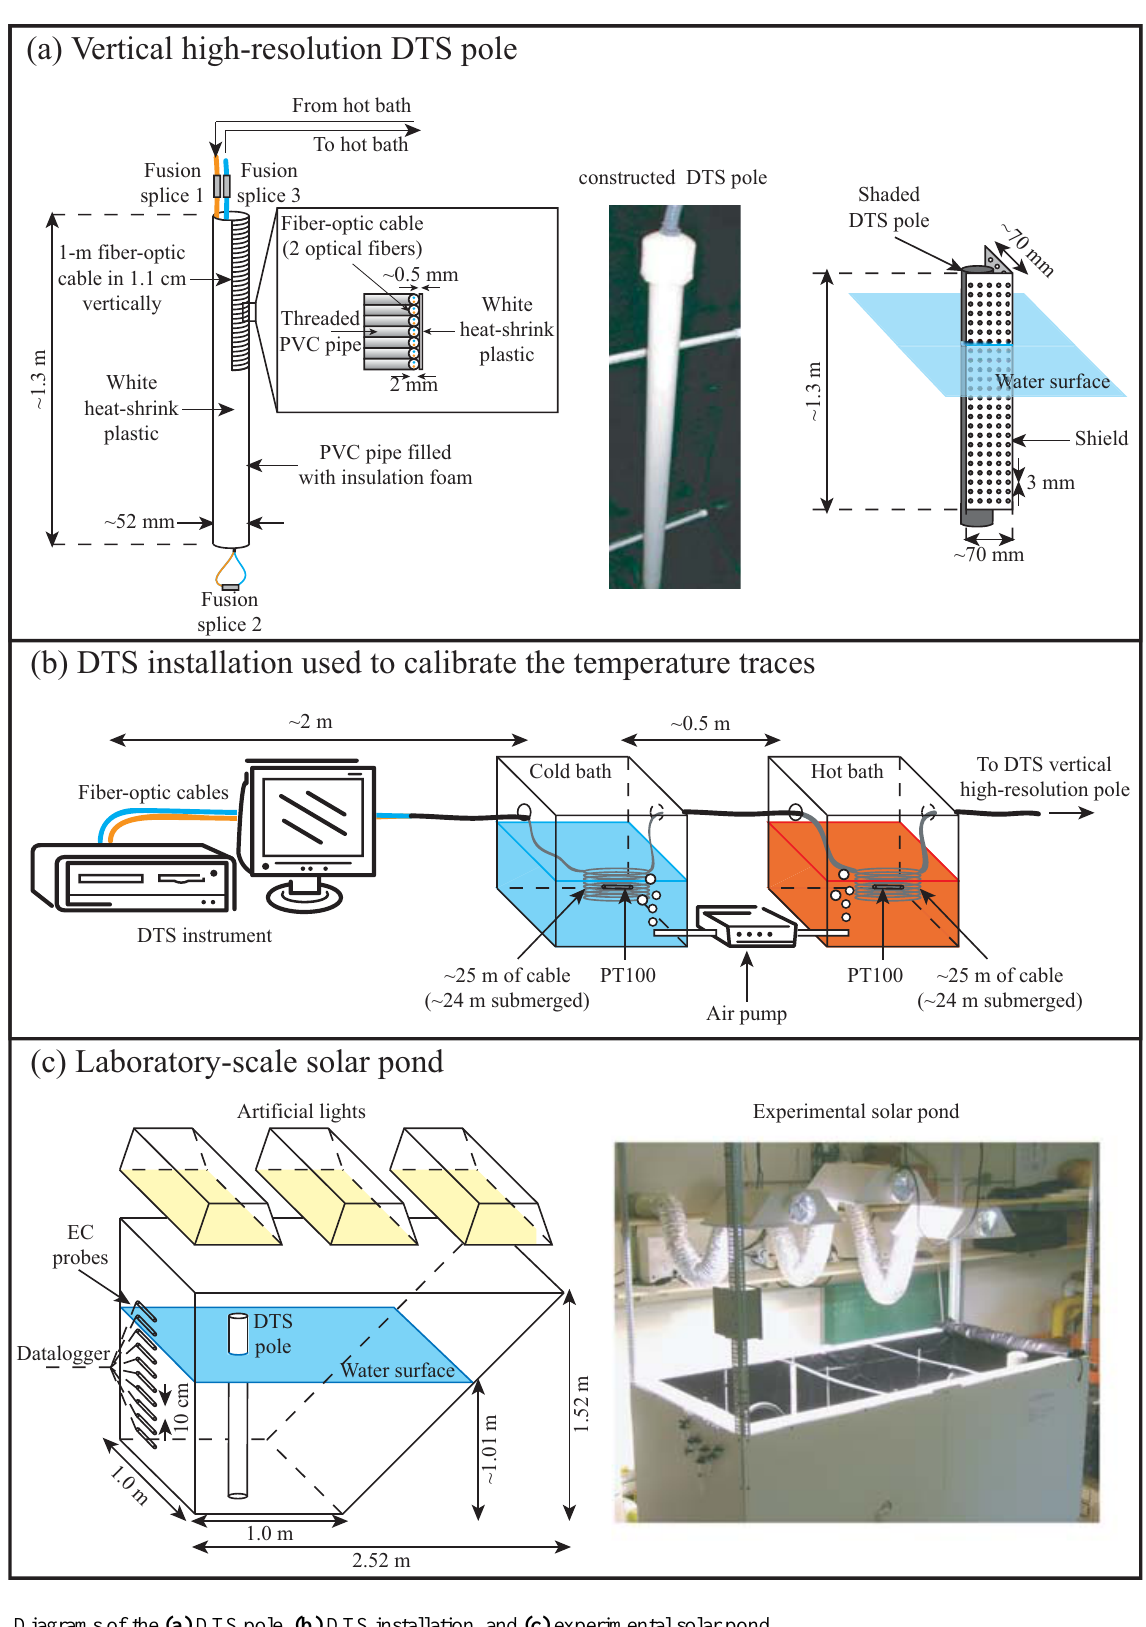
Hydrol. Earth Syst. Sci., 15, 1081–1093,